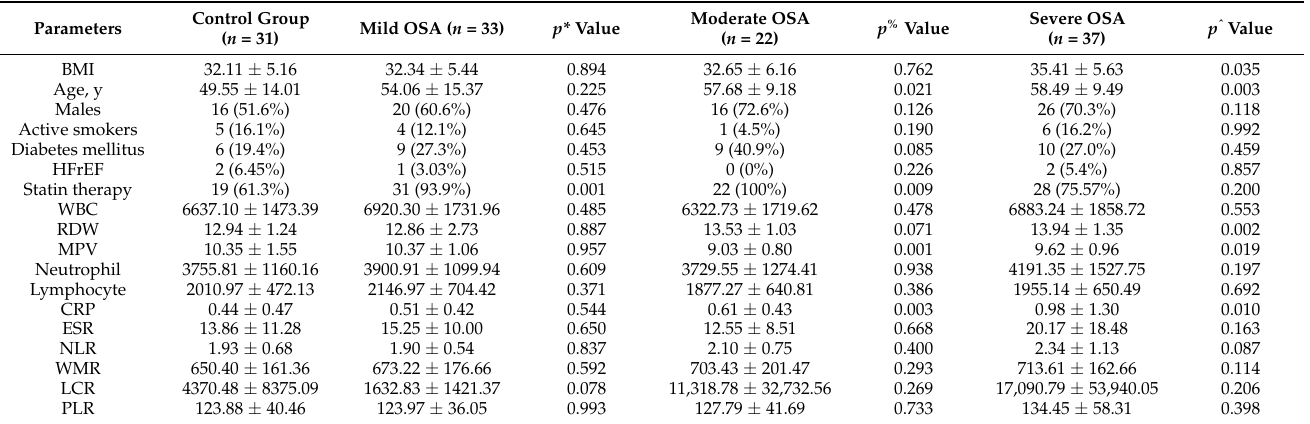
Table 1. Demographic, anthropometric and biological parameters in controls and patients with mild, moderate and severe